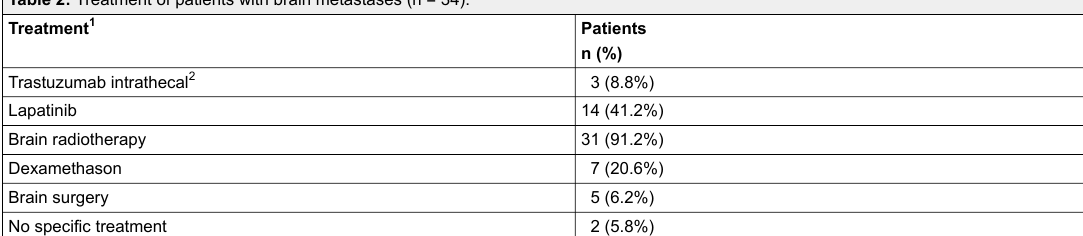
Table 3: Best overall response